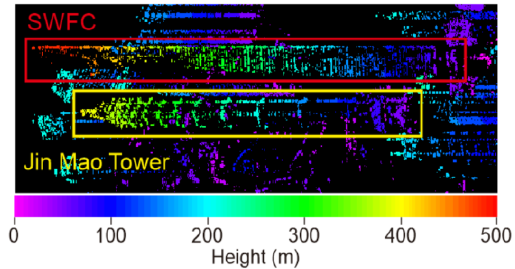
Figure 3. Height map of the two skyscrapers in Shanghai Luijiazui Zone estimated by the Tomo-PSInSAR. The red rectangle in the top figure denotes the SWFC, and the yellow rectangle denotes the Jin Mao Tower.